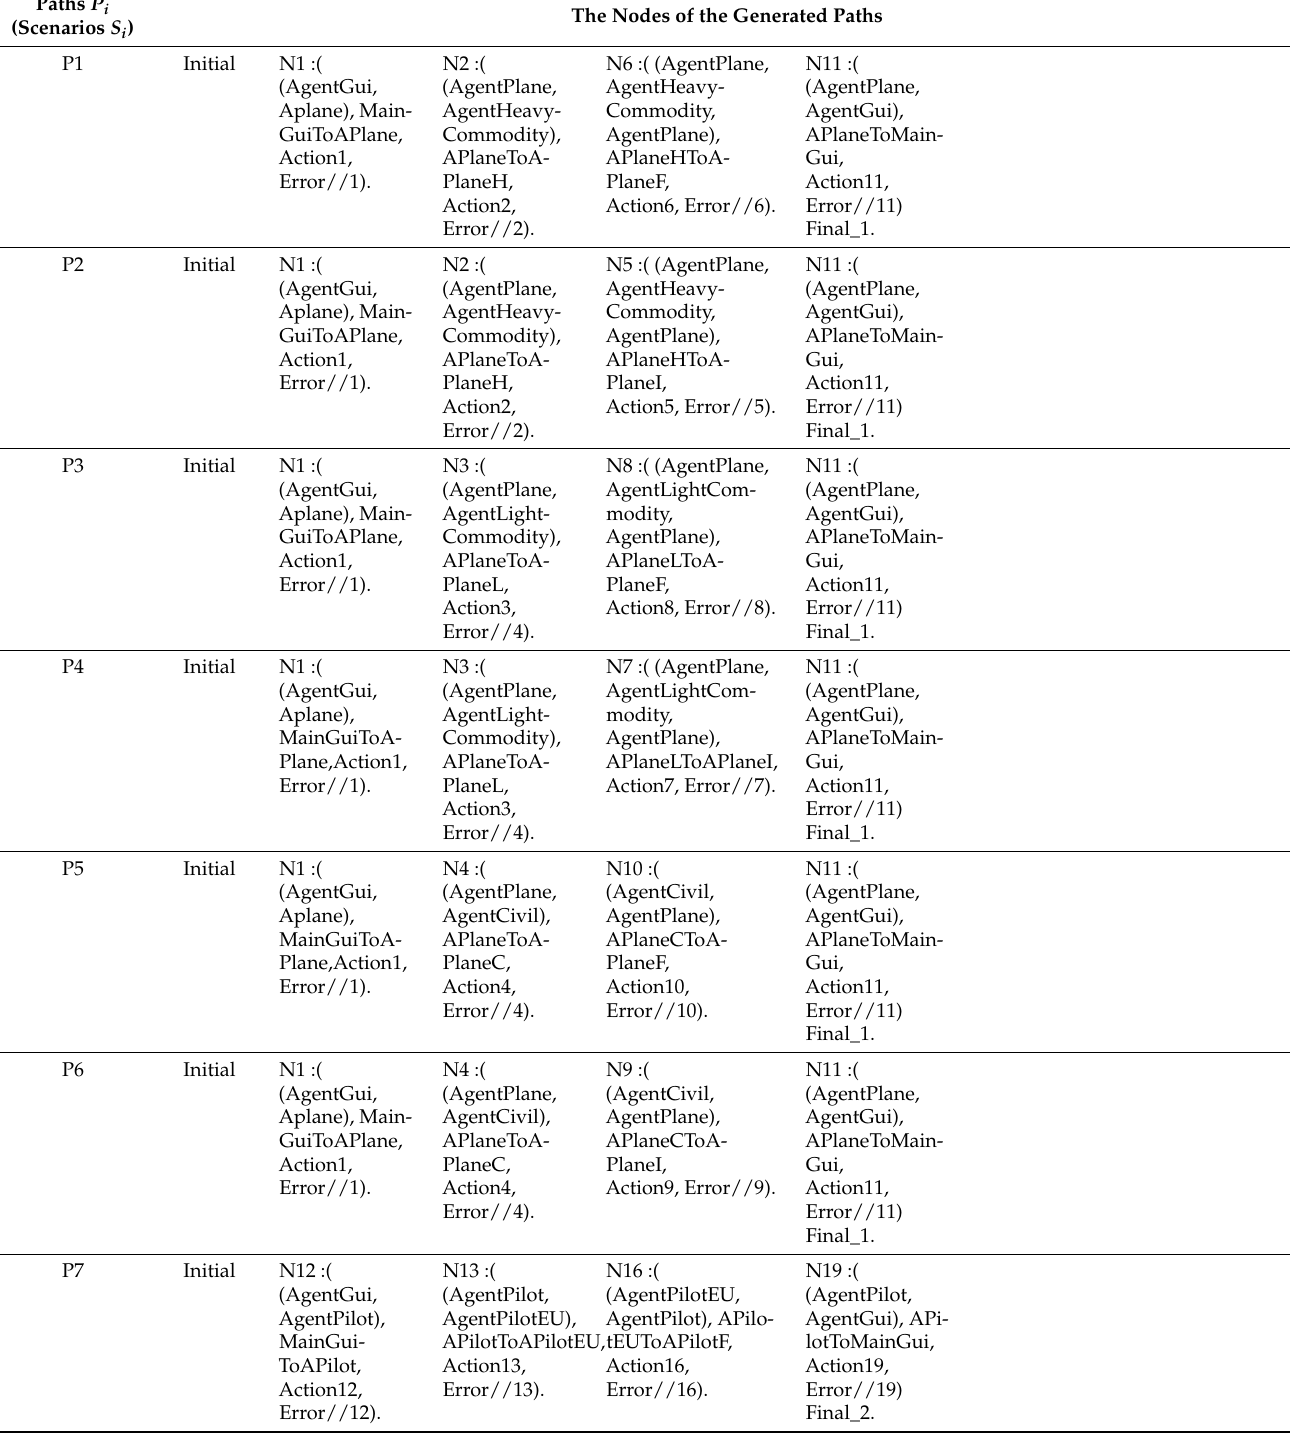
Table 1. Graph paths P i ( System scenarios S i